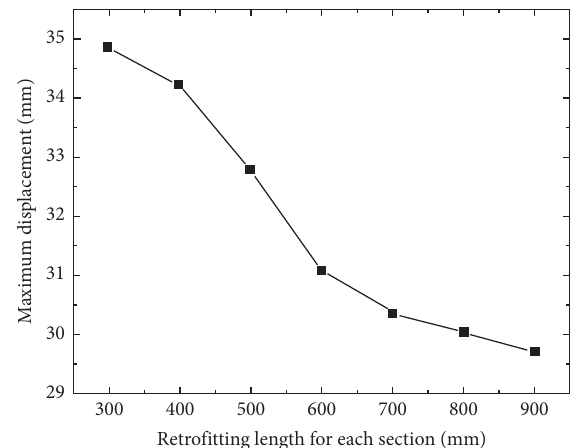
Figure 17: Maximum displacement of columns retrofitted with different retrofitting